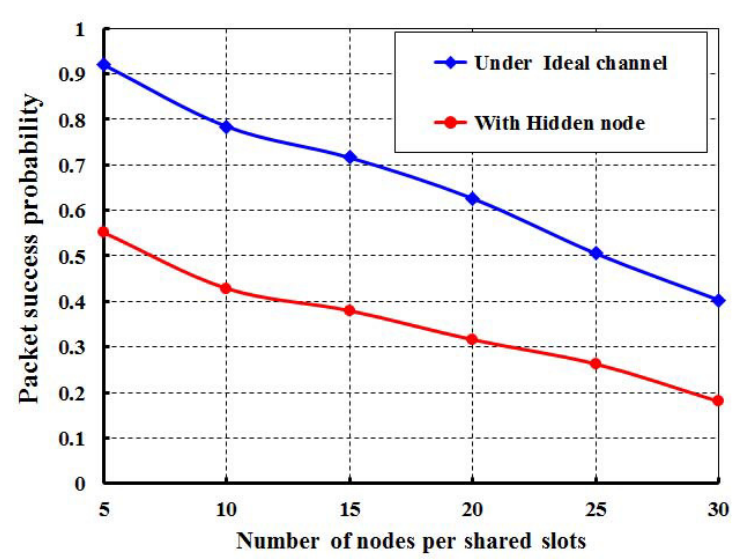
Figure 5. packet success probability with and without hidden nodes.